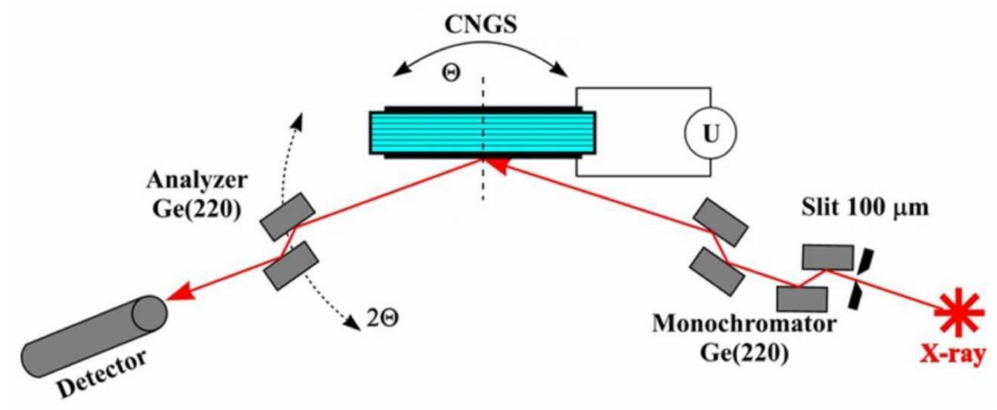
Figure 1. Triple axis x-ray diffractometer scheme for measurements of the independent piezoelectric moduli in the Bragg and Laue diffraction